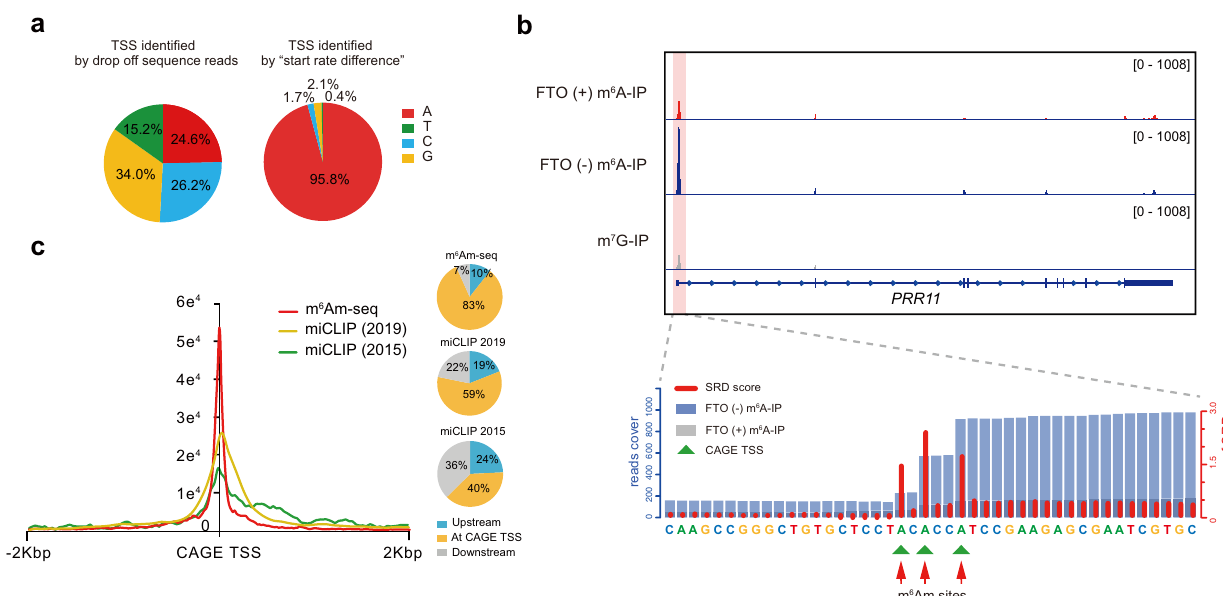
Fig. 4 m 6 Am-seq detects m 6 Am methylome at single-base resolution. a Nucleotide proportion of TSS identi fi ed by the sudden drop-off of sequencing reads (left) and by “ start rate difference ” (SRD) metrics. b A representative view of three single m 6 Am sites on the transcripts of PRR11 , which were all supported by CAGE data. Three adenosine residues with a high SRD score (red bar) were de fi ned as m 6 Am sites, which overlapped exactly with CAGE sites (green triangles). Each segment was normalized according to its average length in RefSeq annotation. Pink background color denotes m 6 Am signal. c A metaplot showing that the vast majority of m 6 Am sites by m 6 Am-seq overlapped with CAGE sites, suggesting that these m 6 Am sites are indeed TSSs. Compared with miCLIP, m 6 Am sites identi fi ed by m 6 Am-seq were much closer to the CAGE TSSs. Two miCLIP data sets were used for comparison: